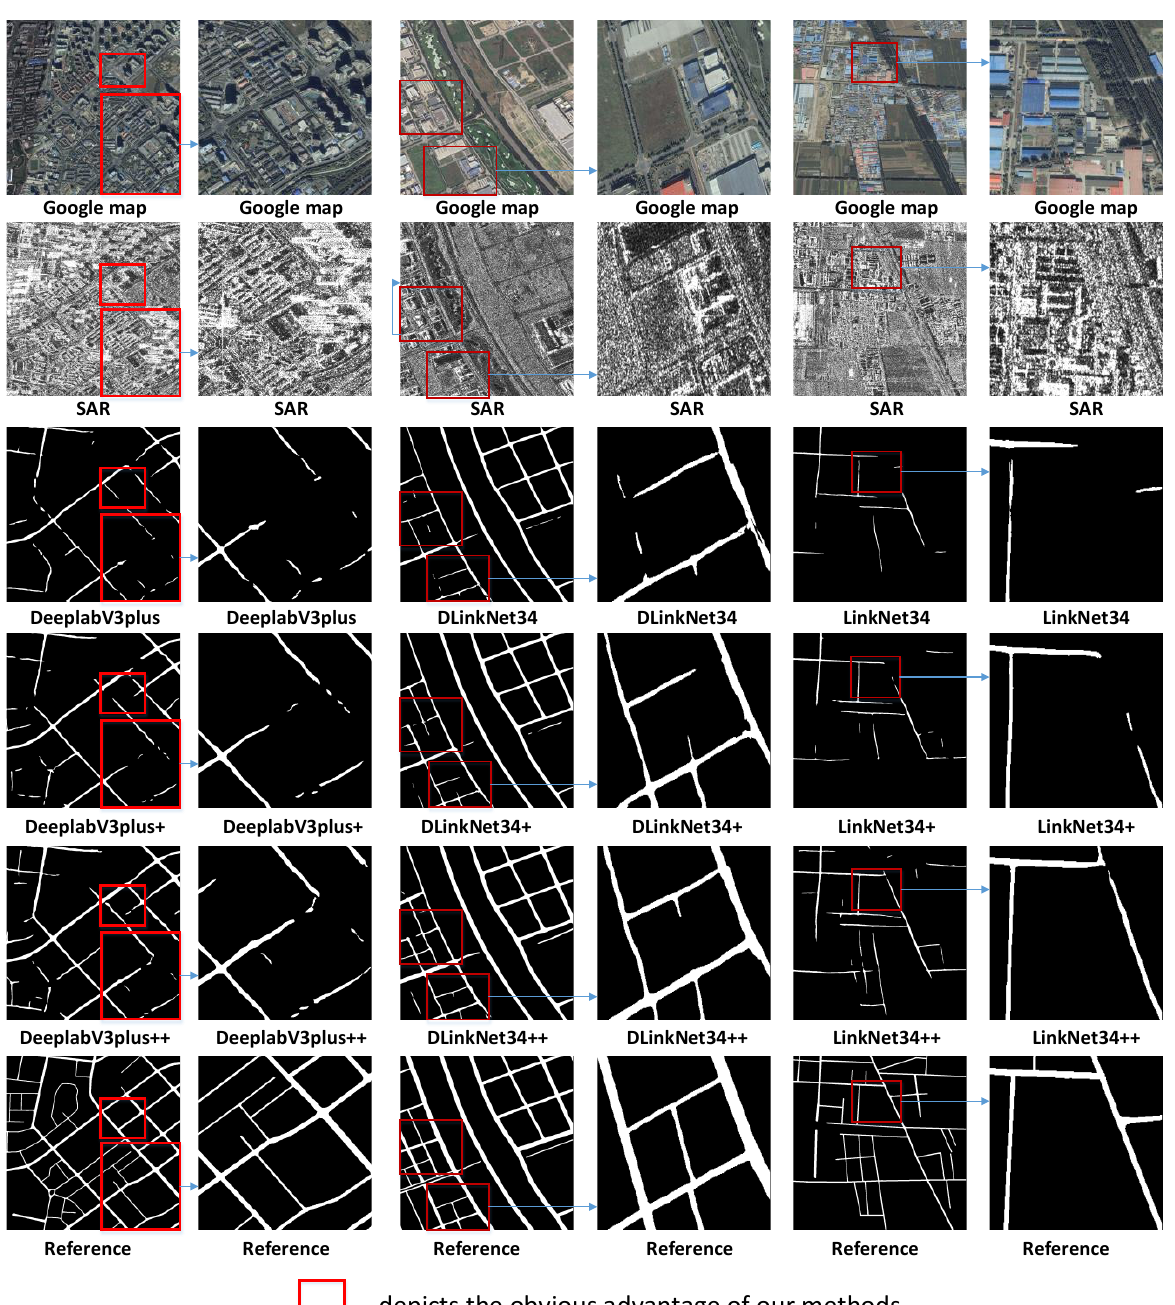
Figure 5. Qualitative comparison of road detection results produced by different methods. As shown in Figure 5, the methods with multitask learning architecture and using road- topology loss function generally perform better than the baseline methods. The baseline methods miss road regions in many places, i.e., the false negative (green) part is large, which leads to the poor connectivity of road detection result. With the learning road detection task and road centerline extraction based on ordinal regression task jointly, the false negative part is smaller. By further using the road-topology loss function that can penalize discontinuous parts of the detected road, the performance of road connectivity is improved. Table 2 presents the comparative quantitative evaluation measured in terms of P, R, IoU, F1. In Table 2, the best value of performance is presented with bold style. We observe from the Table 2 that the proposed methods outperform baselines in terms